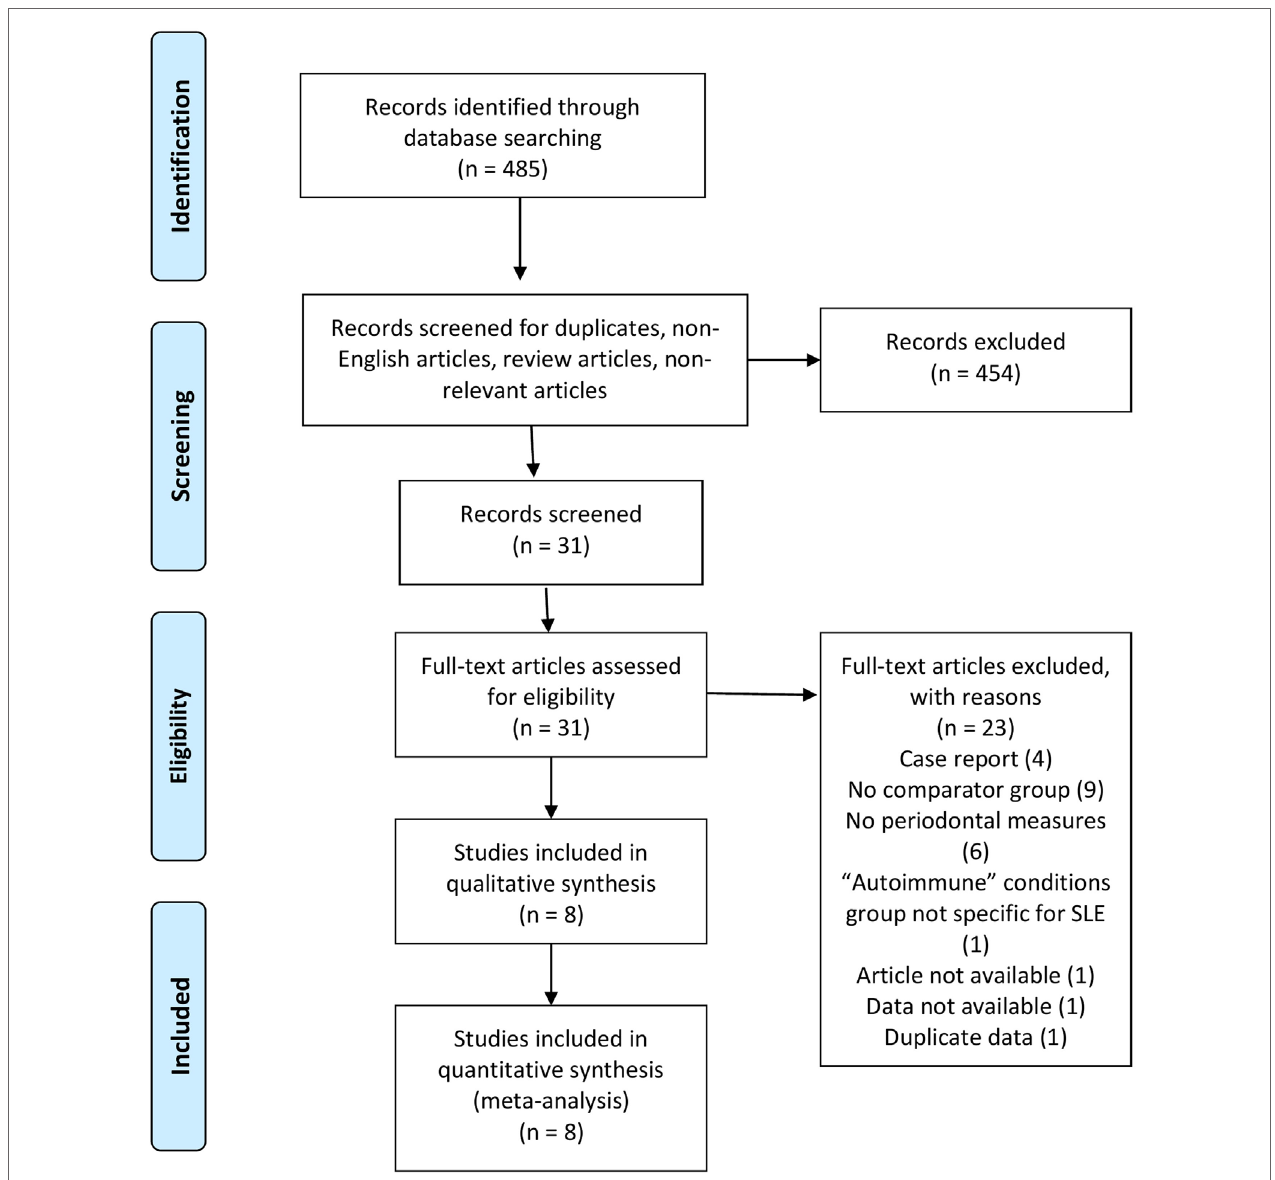
FigUre 1 | PRISMA flow diagram showing results of search